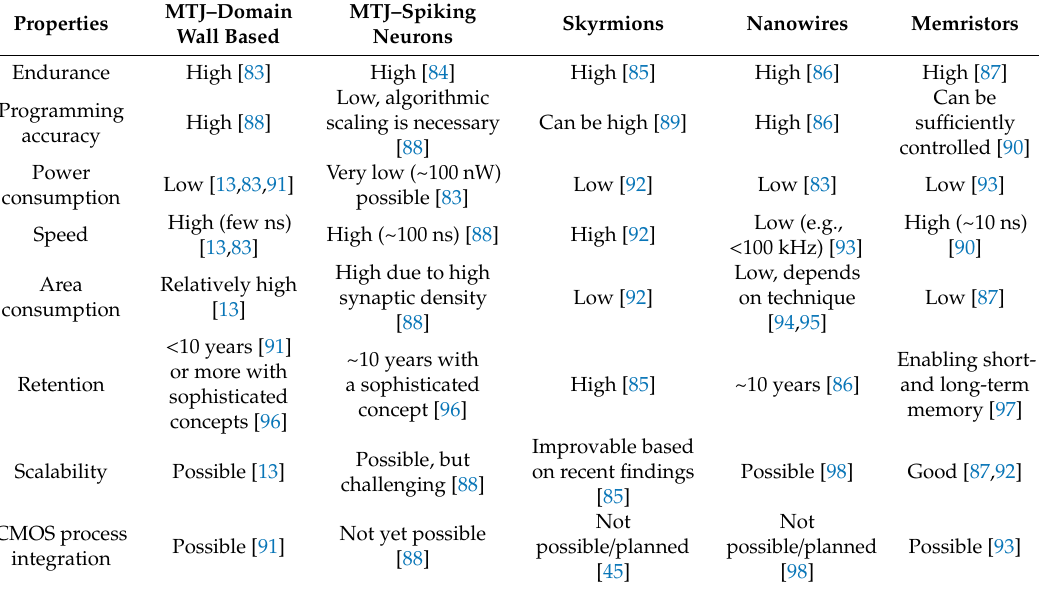
Table 2. Comparison of chosen magnetic elements and memristors for neuromorphic